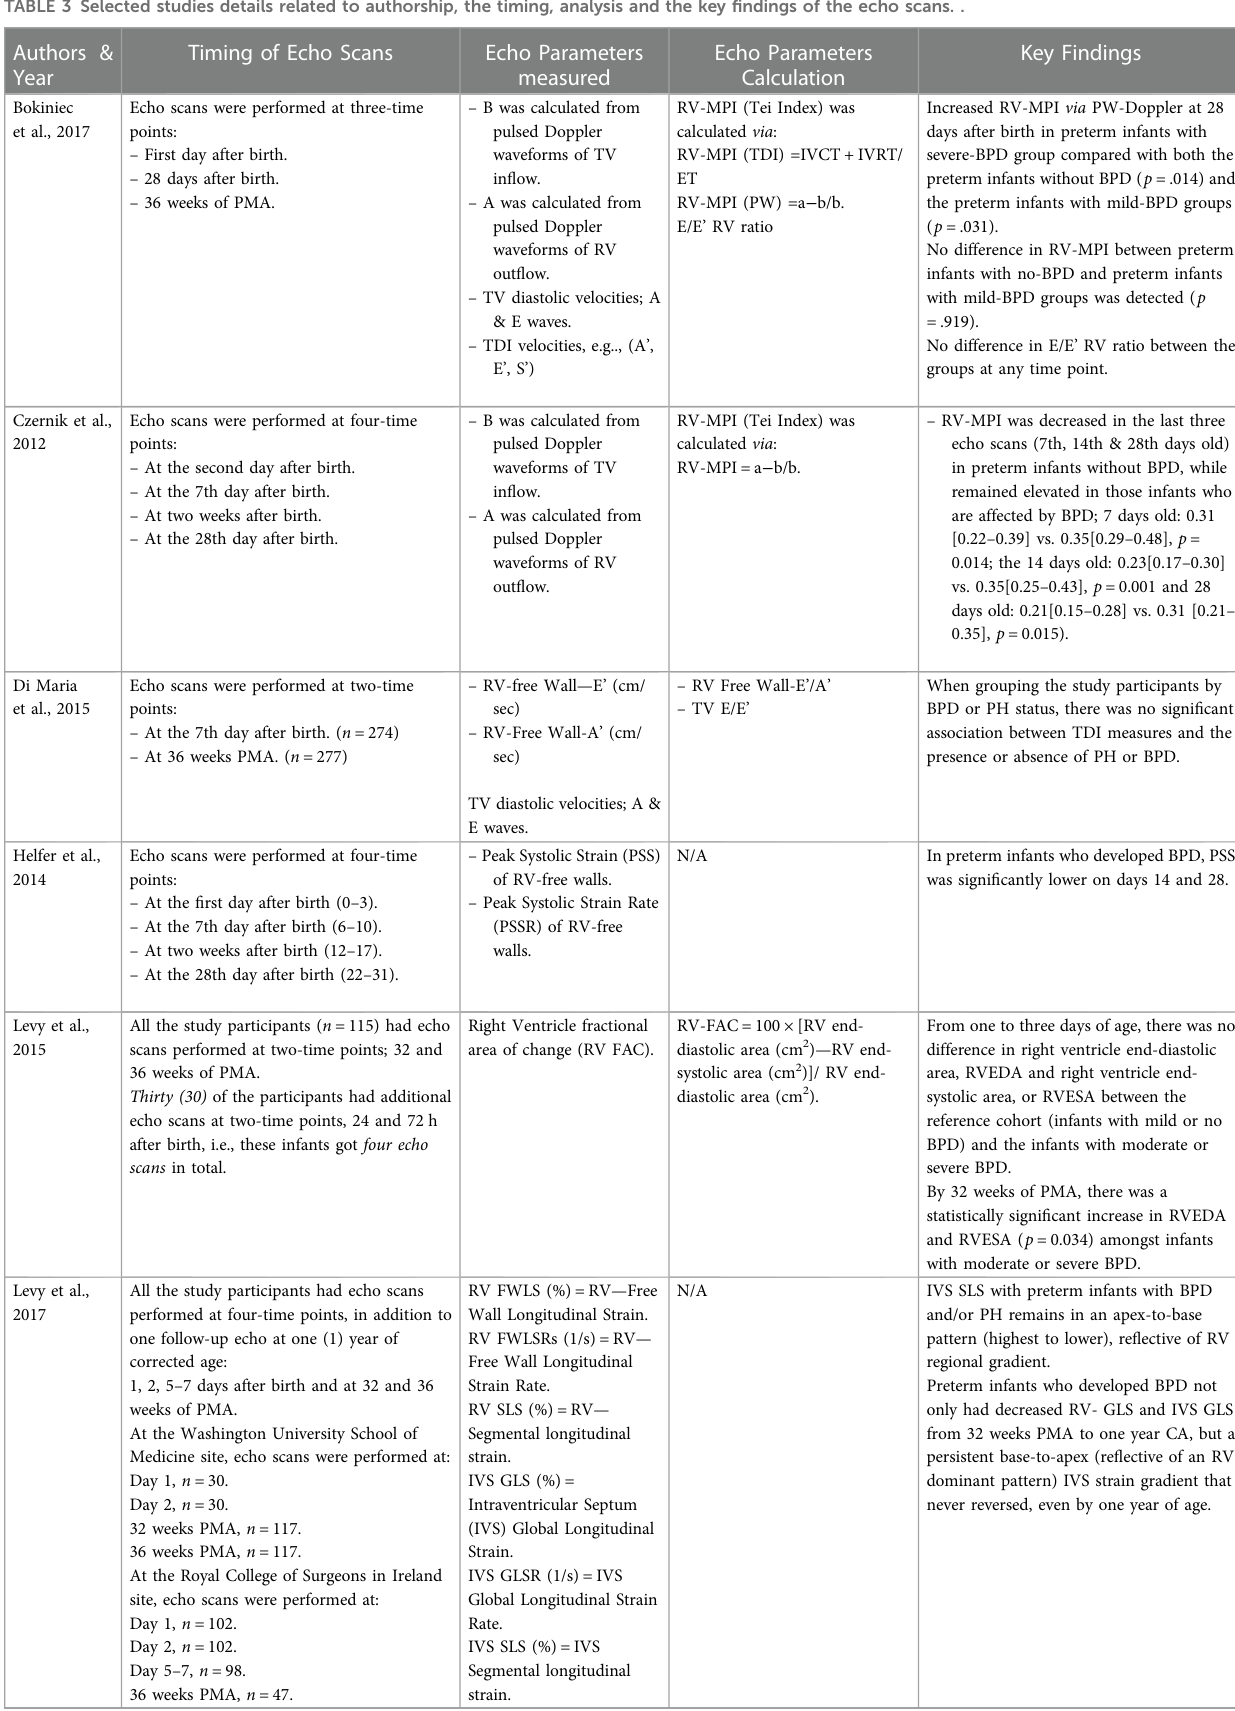
TABLE 3 Selected studies details related to authorship, the timing, analysis and the key fi ndings of the echo scans.